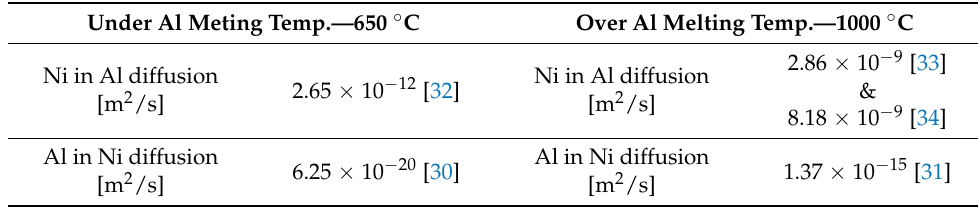
Table 1. Values of diffusion coefficients of Al in Ni andNi in Al.